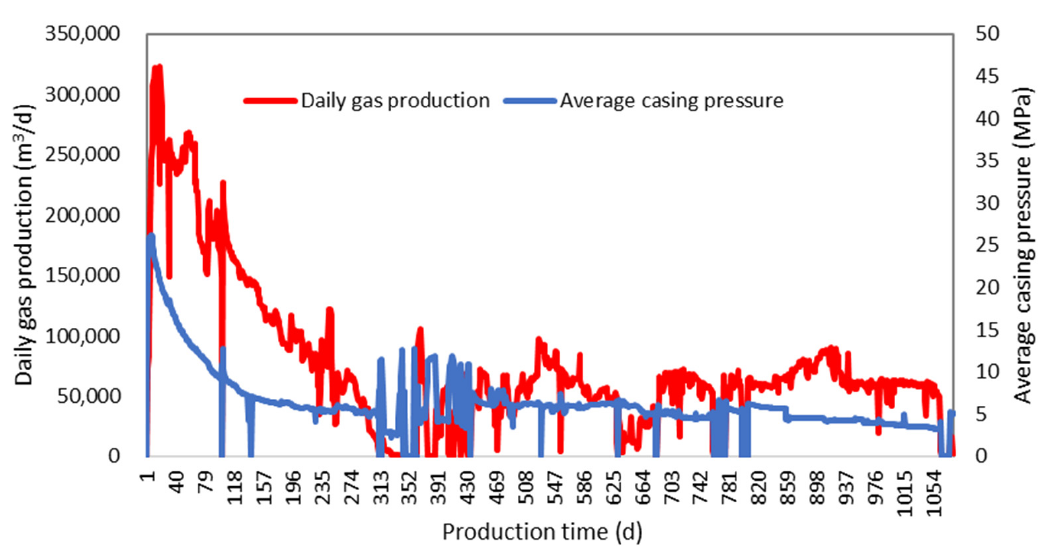
Figure 8. The production history of Well W17 (underestimated).